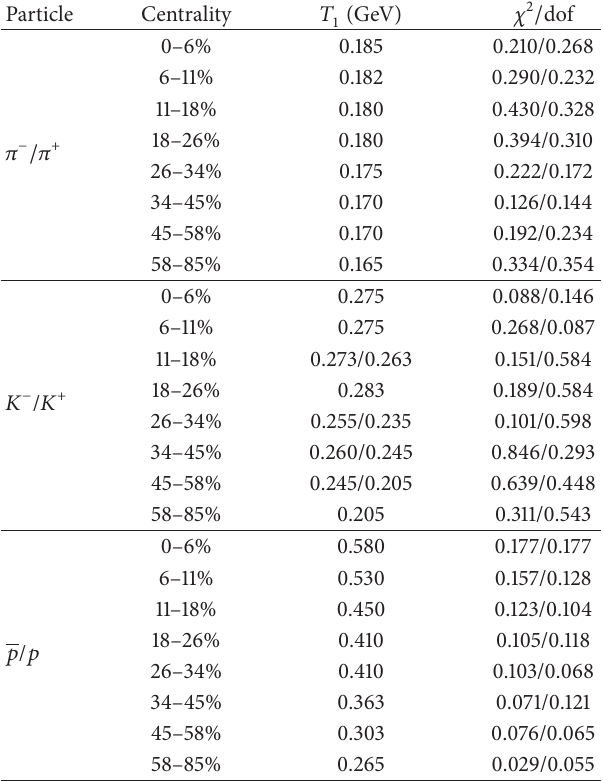
Table 6: Parameter values corresponding to the curves in Figure 6(a)/Figure 6(b). The collisions are Au + Au at